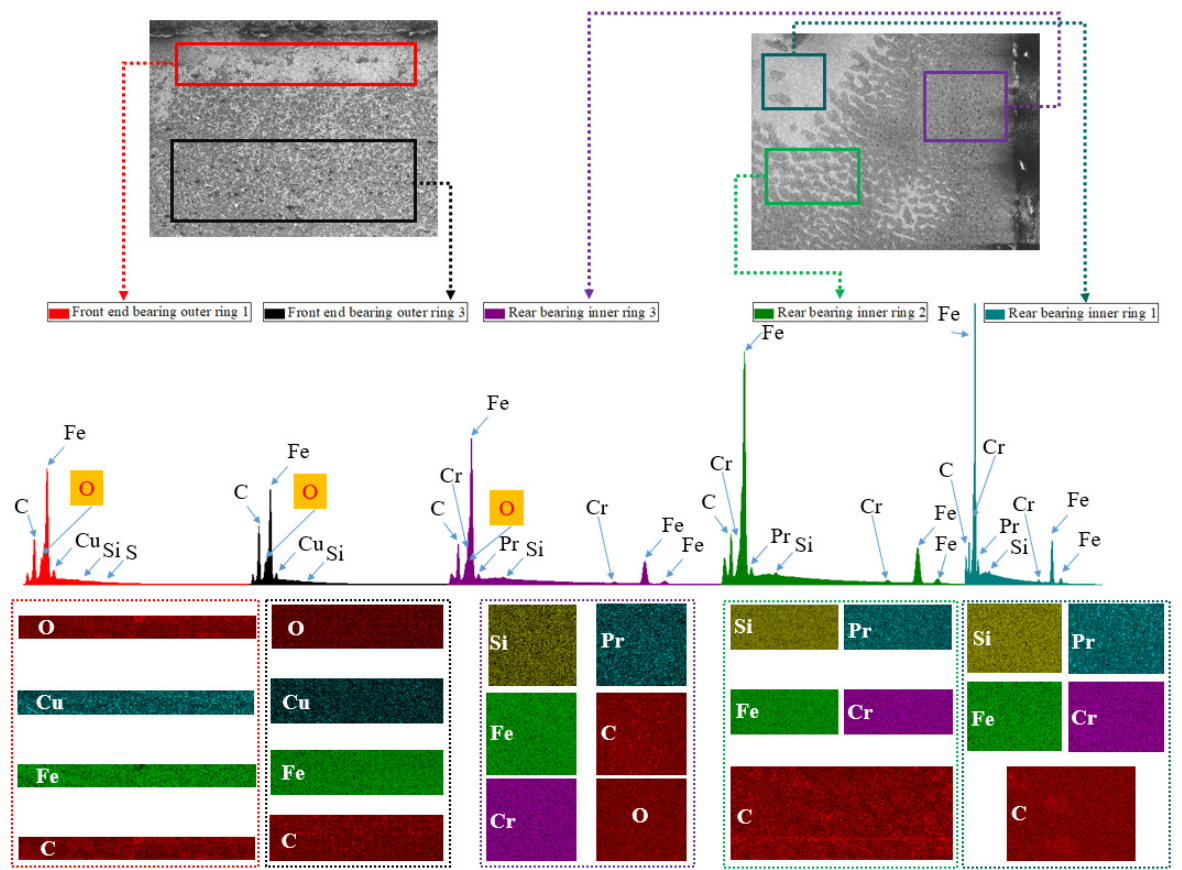
Figure 9. EDS of the wear delamination of the outer and inner rings of the front-end and rear high-performance bearings. Table 1. EDS results of the wear delamination of the inner and outer rings of the front-end and rear bearings.